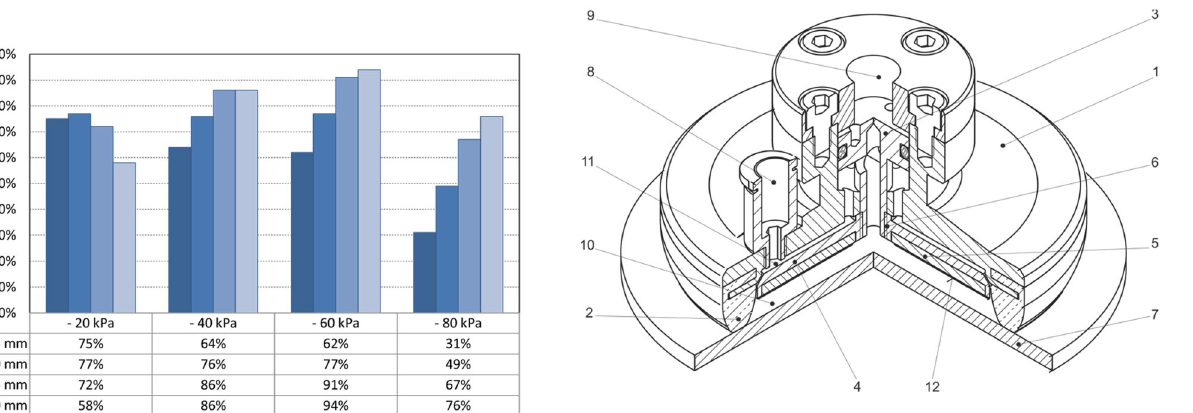
Fig. 25 Increase in the loading capacity of the gripping element